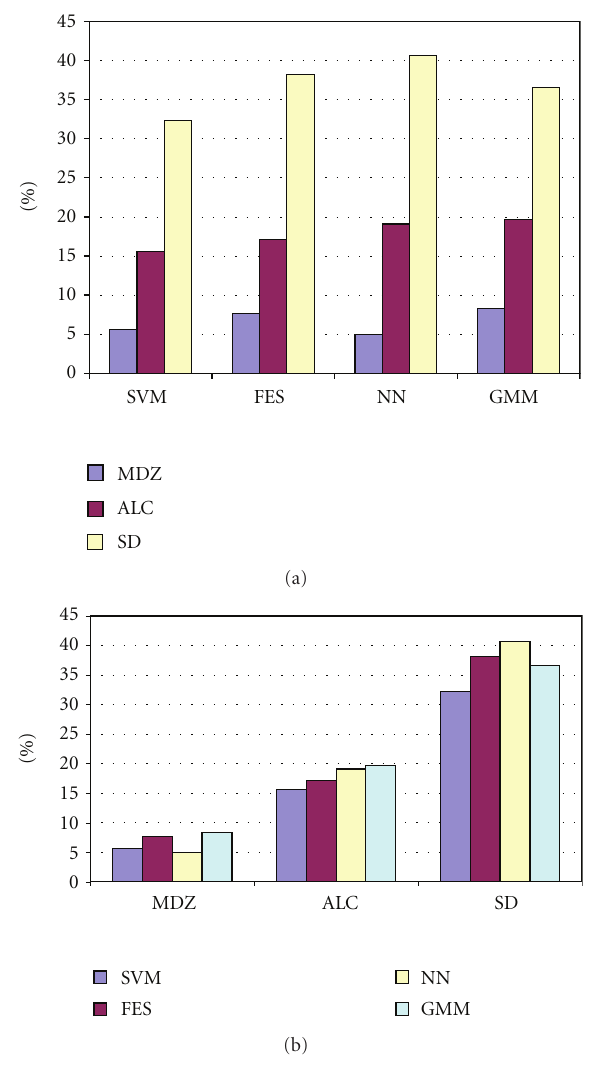
Figure 3: HTER grouped by algorithm for each abnormal con- dition (a) and HTER grouped by abnormal condition for each algorithm